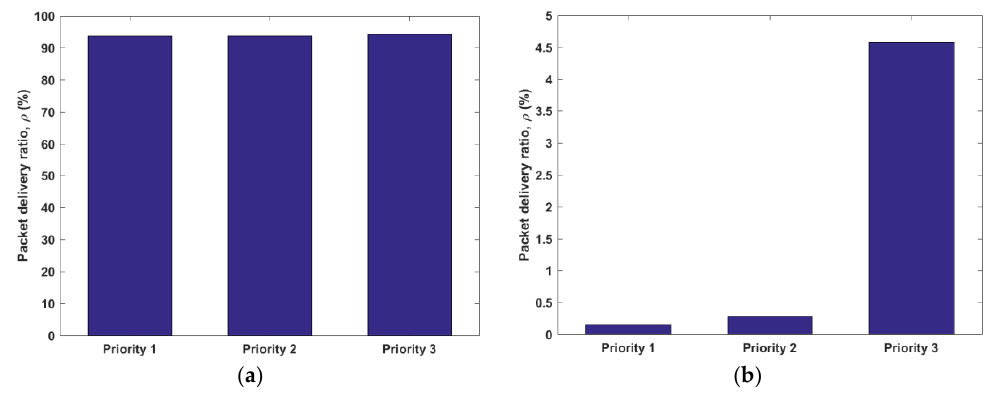
Figure 5. Packet delivery ratio (PDR) for each protocol with λ = 1.25 packet per second, ( a ) OrMAC ( b ) distributed queuing collision avoidance protocol (DQCA). distributed queuing collision avoidance protocol (DQCA). Table 3. Mean PDR (%) for different values of λ. Table 3. Mean PDR (%) for different values of λ